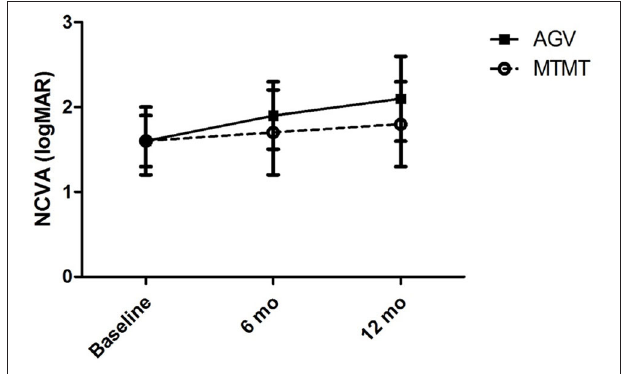
FIGURE 1 | Changes in the non-corrected visual acuity (NCVA) after glaucoma treatment. No significant difference was found between the two groups, and between before and after the treatment in each group.